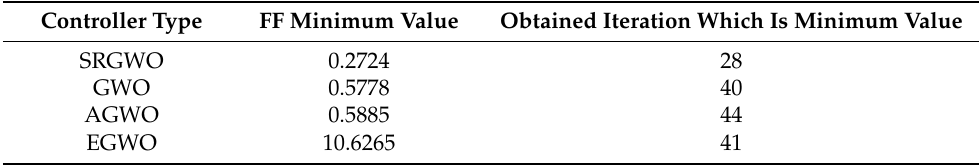
Table 5. The convergence values of SRGWO, GWO, AGWO, and EGWO. Controller Type